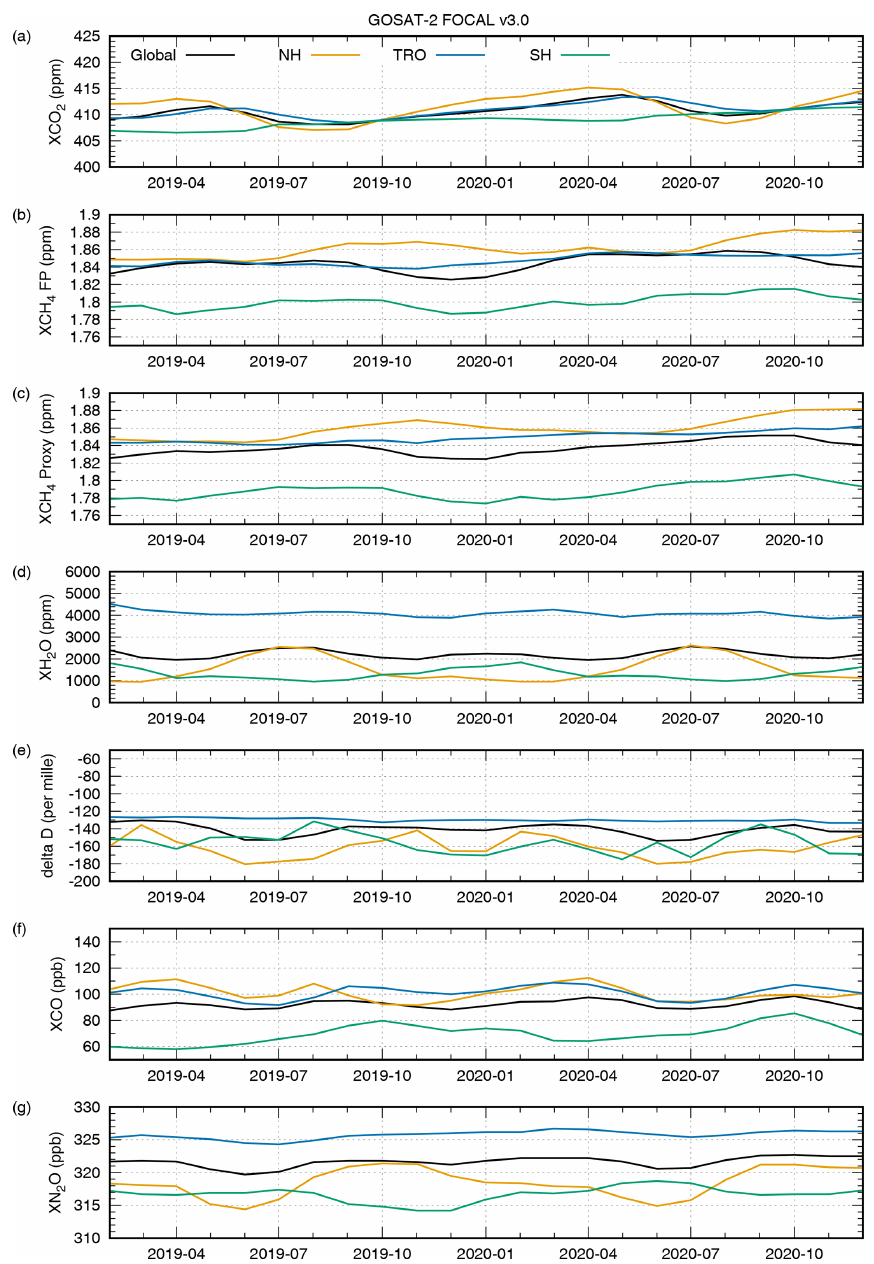
Figure 10. GOSAT-2 time series. NH = Northern Hemisphere ( > 25 ◦ N). TRO = tropics (25 ◦ S–25 ◦ N). SH = Southern Hemisphere ( < 25 ◦ S). (a) XCO 2 ; (b) XCH 4 full-physics product; (c) XCH 4 proxy product; (d) XH 2 O; (e) δ D; (f) XCO; (g) XN 2